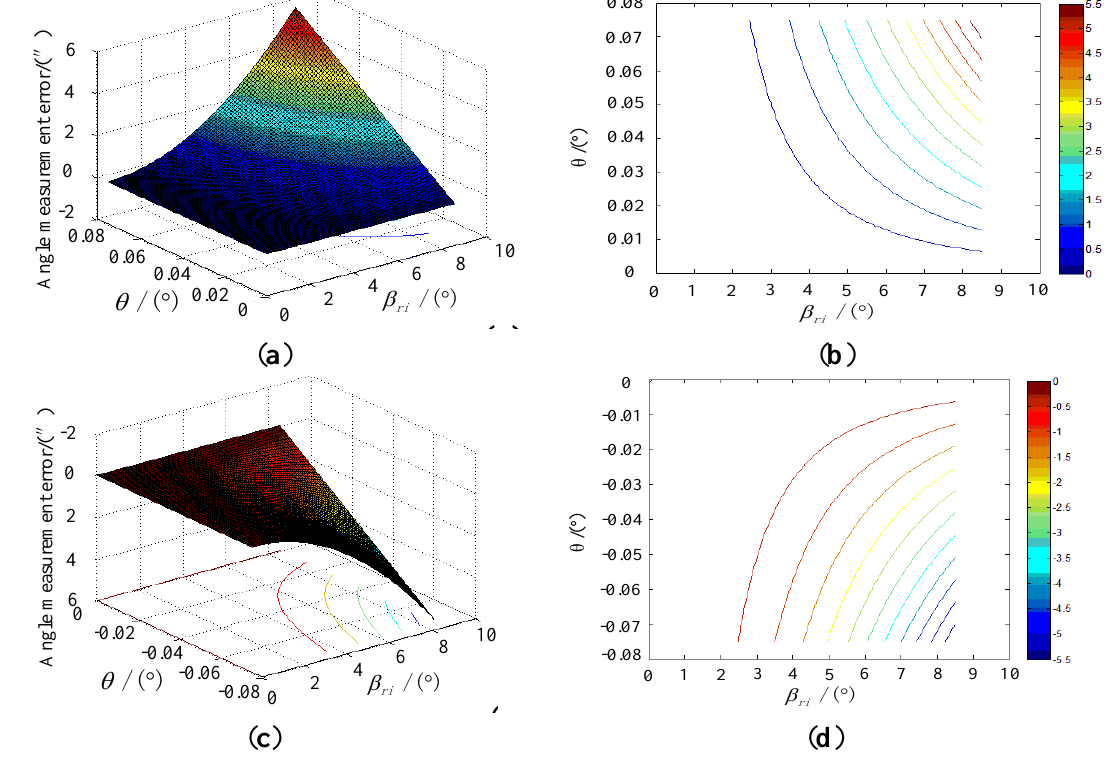
Figure 7. Influence of the inclination angle error on the star tracker accuracy. ( a ) is obtained when θ is in the range from 0° to 0.075°.( b ) is the contour line of (a). ( c ) is obtained when θ is in the range from −0.075° to 0°, and ( d ) is the contour line of (c).